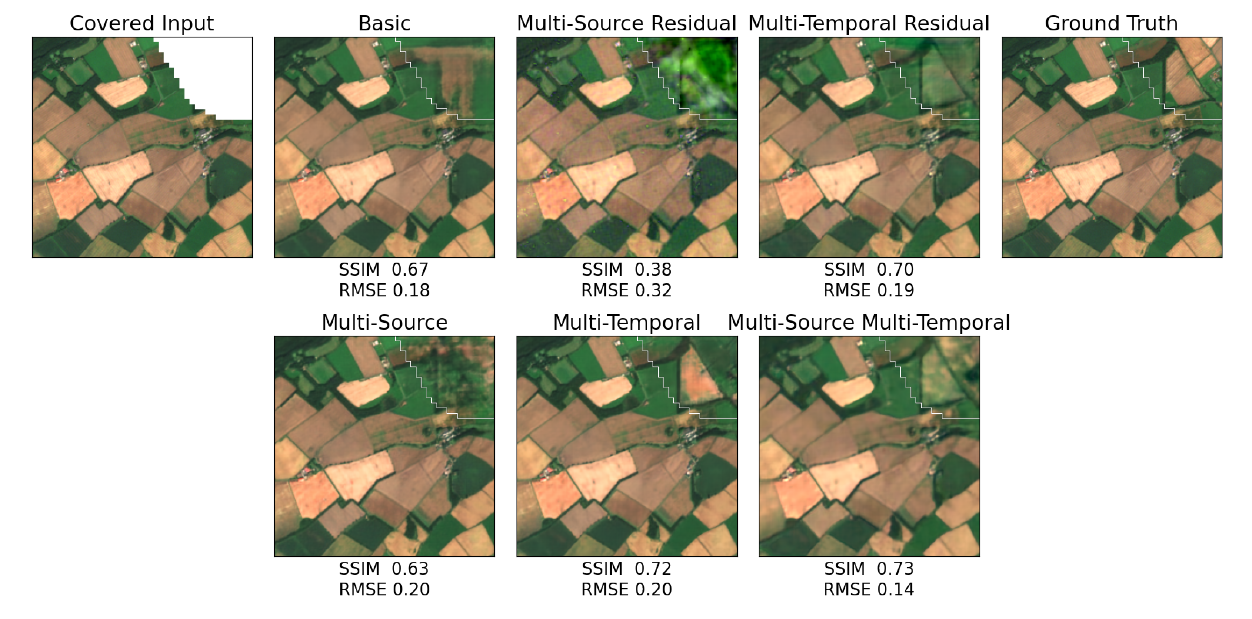
Figure 4. Comparison of DIP-based synthesis approaches. Median score samples from 4 repeated runs are shown. Metric values are given for the inpainting